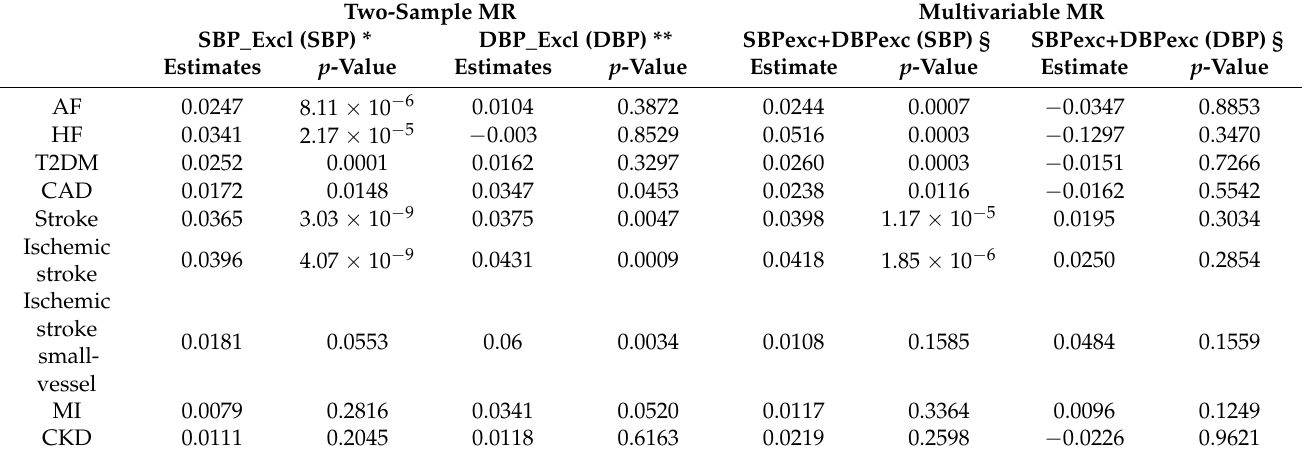
Figure 4. Multivariable Mendelian randomization estimates (odds ratio with 95% confidence interval per 10 mmHg increase in genetically predicted systolic blood pressure, and per 5 mmHg increase in genetically predicted diastolic blood pressure) using systolic-blood-pressure-exclusive and diastolic-blood-pressure-exclusive SNPs as genetic instruments. * p -value of 0.004 is the Bonferroni-corrected p -value in this study. Table 2. Two-sample and multivariable Mendelian randomization estimates of the effects of systolic and diastolic blood pressure on the outcomes. MR, Mendelian randomization; SBP, systolic blood pressure; DBP, diastolic blood pressure; AF, atrial fibrillation; HF, heart failure; T2DM, type 2 diabetes; CAD, coronary artery disease; MI, myocardial infarction; CKD, chronic kidney disease. * SBP-exclusive SNPs. ** DBP-exclusive SNPs. § SBP-excusive SNPs and DBP-exclusive